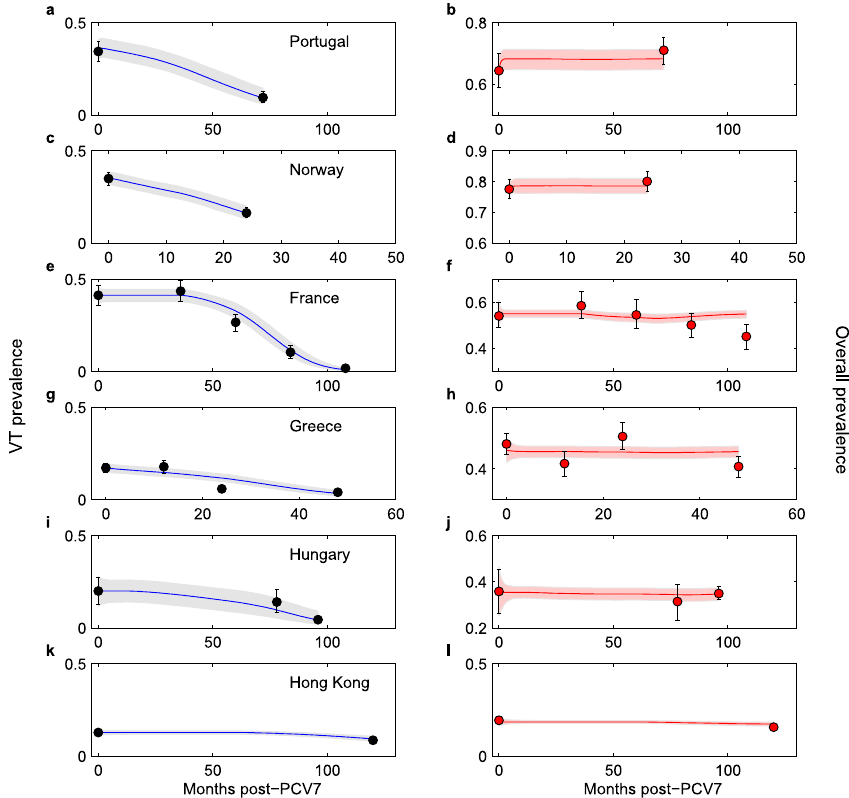
Figure 4. Observed and fitted prevalence of asymptomatic carriage of pneumococcus in day care centres by country. The model-predicted 95% credible envelopes for temporal trajectories of VT prevalence (left panels) and overall prevalence (right panels) after vaccination are superimposed on observed data in different day care settings at specific time-points. ( a , b ) Portugal. ( c , d ) Norway. ( e , f ) France. ( g , h ) Greece. ( i , j ) Hungary. ( k , l ) Hong Kong. The credible envelopes were computed using 500 simulations with different parameter combinations sampled from the joint posterior, and here account only for the uncertainty around parameter values and initial conditions. For the credible envelopes accounting for sampling uncertainty throughout time (with mean sample size as in Table 1) see Fig.